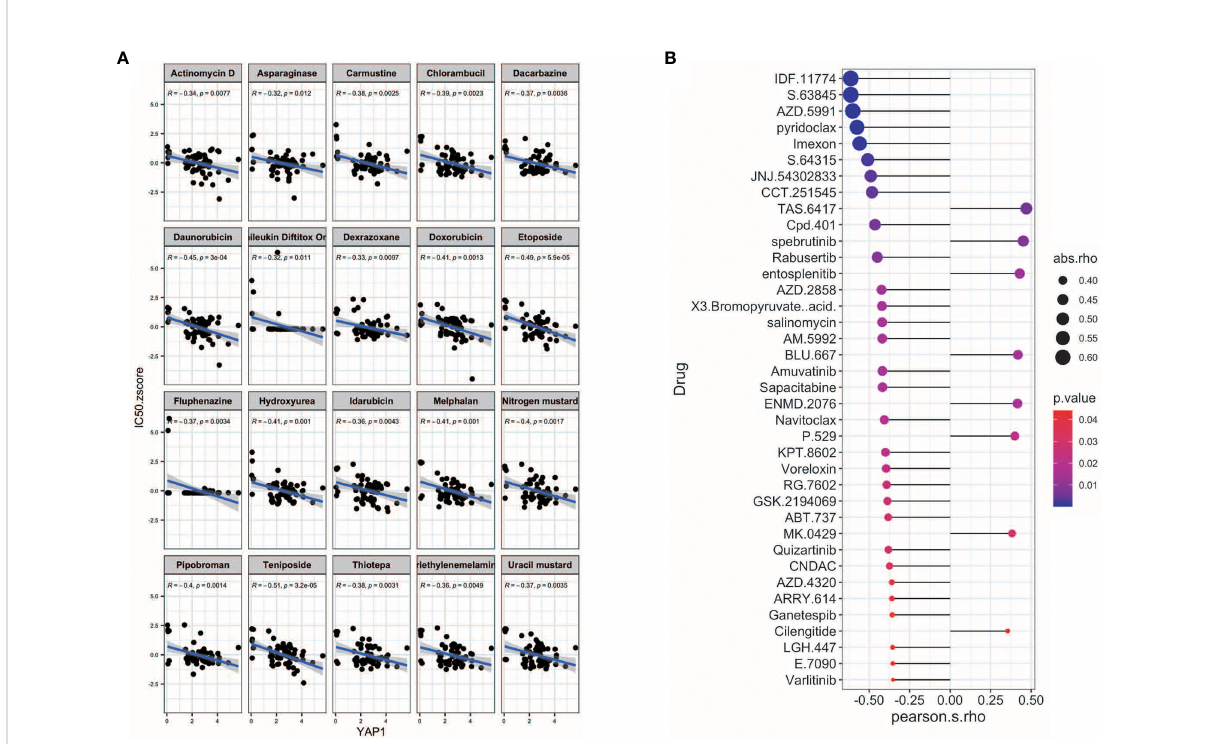
FIGURE 7 Potential drugs for YAP1 . (A) Correlation of YAP1 expression with and IC 50 z score of FDA-approved drugs (top 25). (B) Correlation of YAP1 expression and IC 50 of drugs in clinical